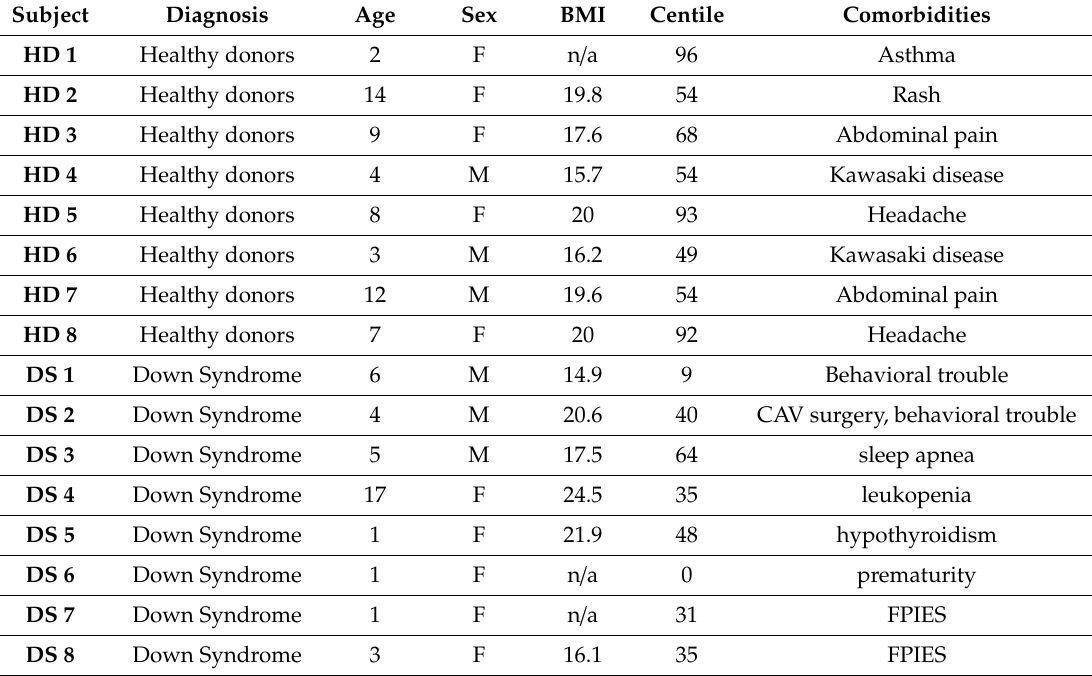
Table 1. Clinical characteristics of Down syndrome (DS) and healthy donors (HD)